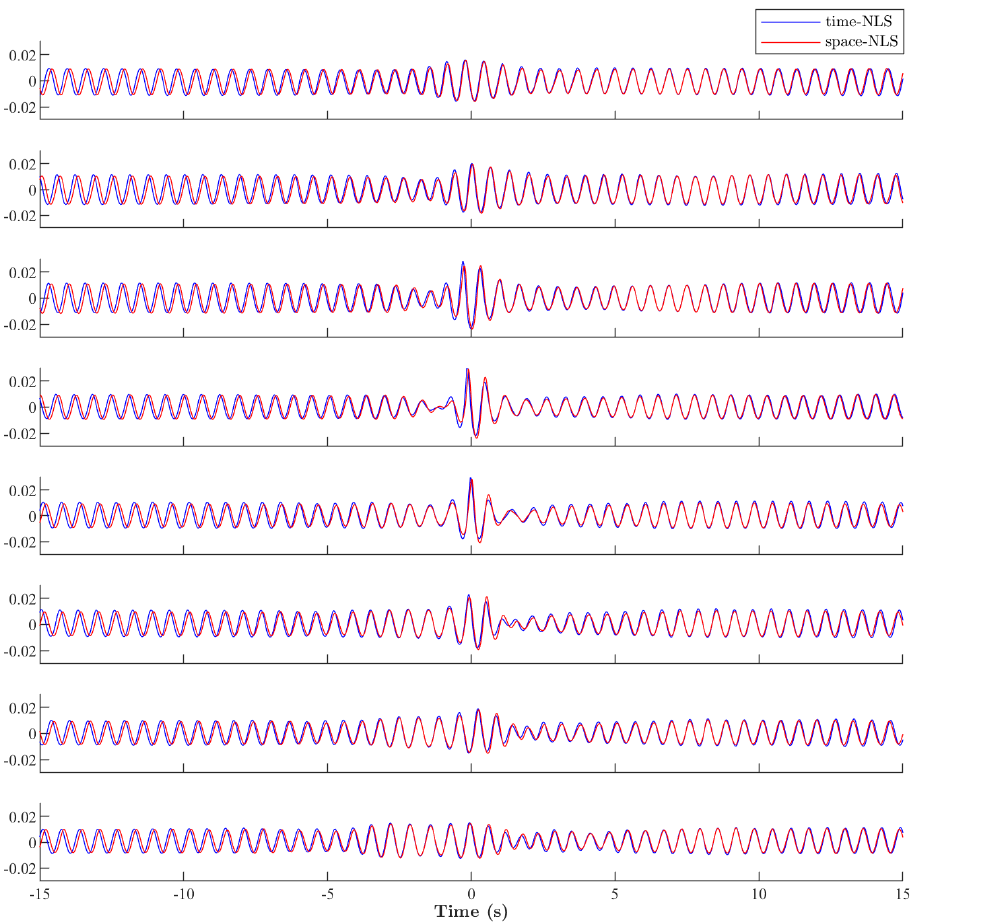
Figure 5. Superposition and comparison of measured Peregrine hydrodynamics along the wave tank for ak = 0.10, a = 0.01 m and x 0 = − 14 m and according to the time-like (blue lines) and space-like NLSE (red lines)